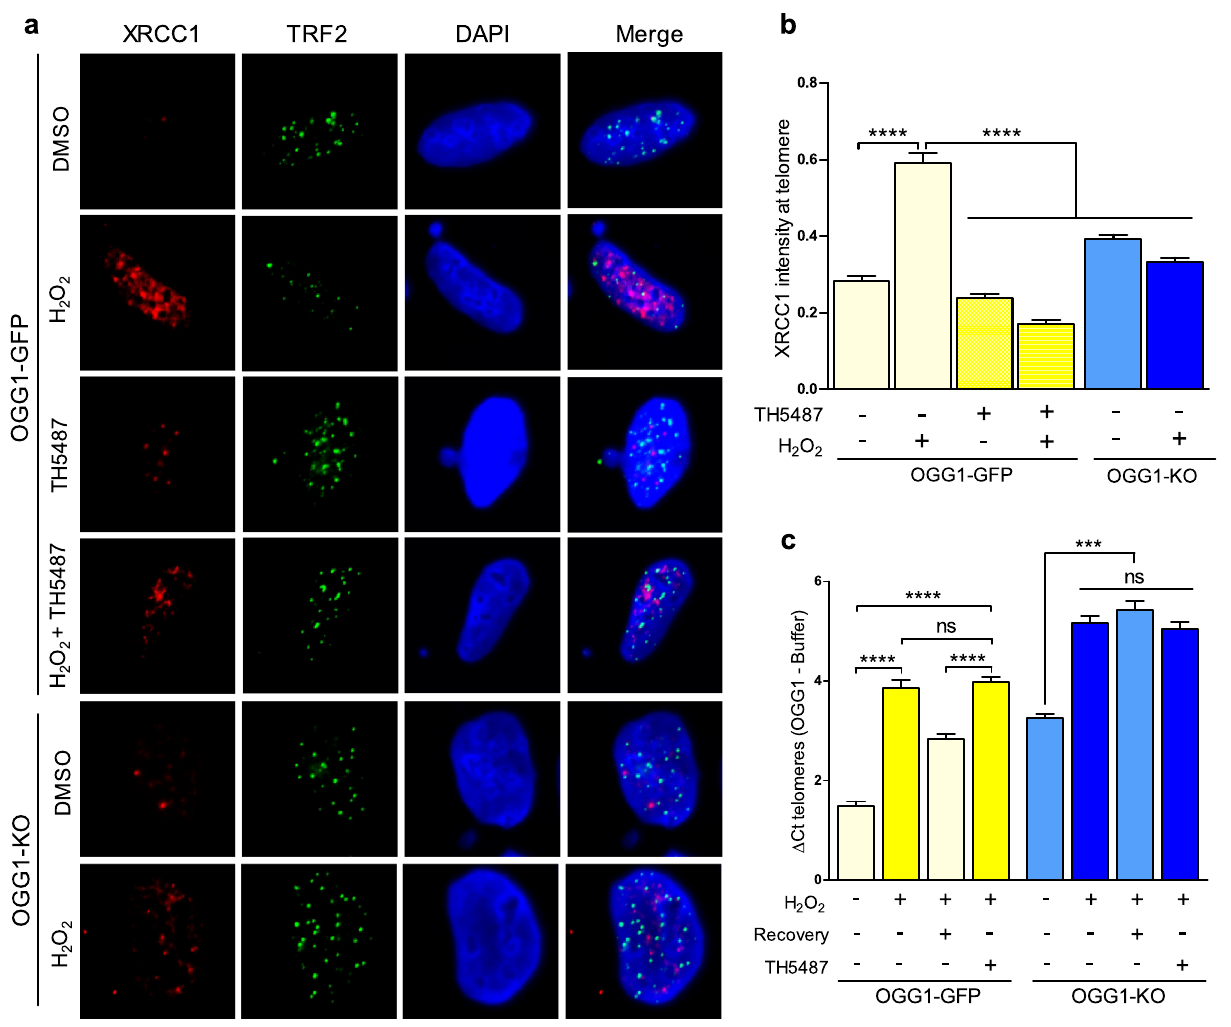
Figure 2. Pharmacological OGG1 inhibition disrupts BER at telomeres upon OS. ( A ) Confocal imaging of XRCC1 (red) and TRF2 (green) by IF using specific antibodies. DAPI was used to stain the cell nucleus (blue). ( B ) Quantification of XRCC1 signal intensity integrated within telomeres from more than 200 foci per condition. Data represent average with SEM from 2 independent experiments (Mann–Whitney test; **** P < 0.0001). ( C ) Relative level of oxidized bases at telomeres in OGG1 inhibited/depleted U2OS cells upon OS treatment (H 2 O 2 200 µM/1 h) or followed by a recovery period (fresh media/1 h). Bars show the mean and the SEM from 3 technical replicates from 6 independent experiments for each condition (two-sided T-test; *** P < 0.001, ns: not